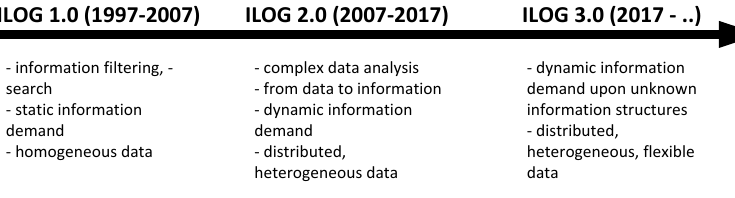
Figure 1. History and future of Information